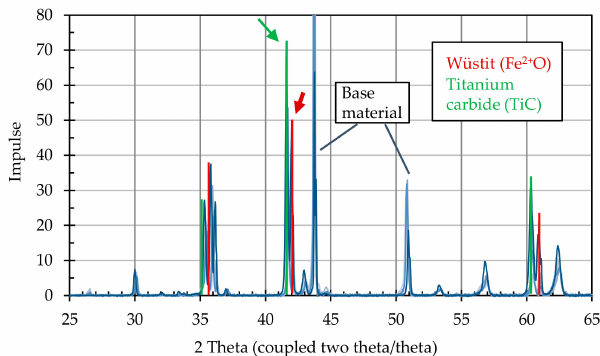
Figure 8. XRD measurement of Alloy 800H with the identification of the decisive compounds (Fe 2 + O and TiC).